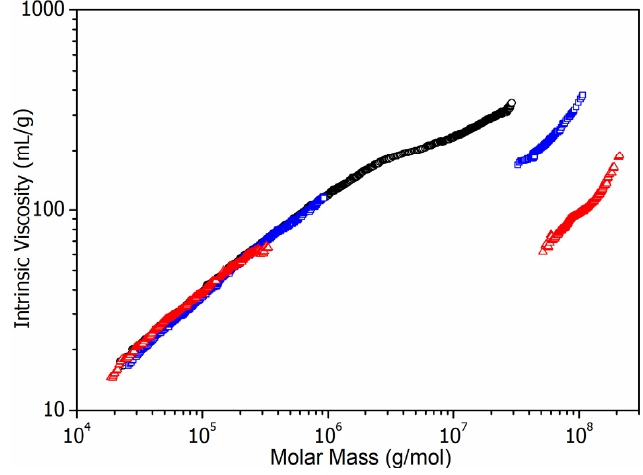
Figure 6. Mark–Houwink plots of reference copolymer (black) and copolymers modified with 20 wt.% of AME_OA (blue), and 20 wt.% of AME_RO (red).